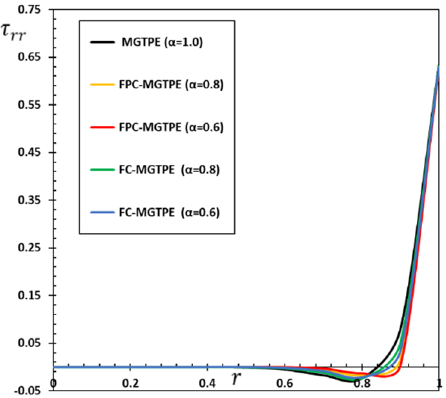
Figure 6. Maxwell’s stress 𝜏 (cid:3045)(cid:3045) for different fractional derivatives.